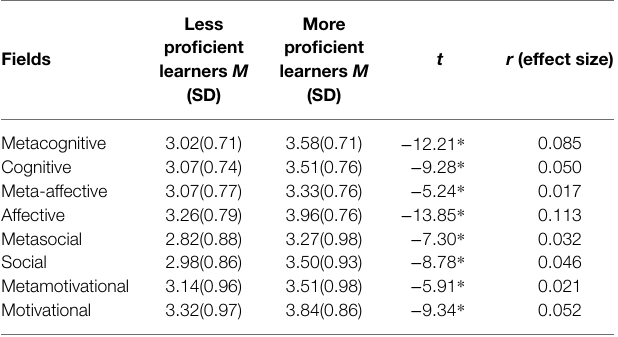
TABLE 2 | Frequency of language learning strategy use among less and more proficient learners.